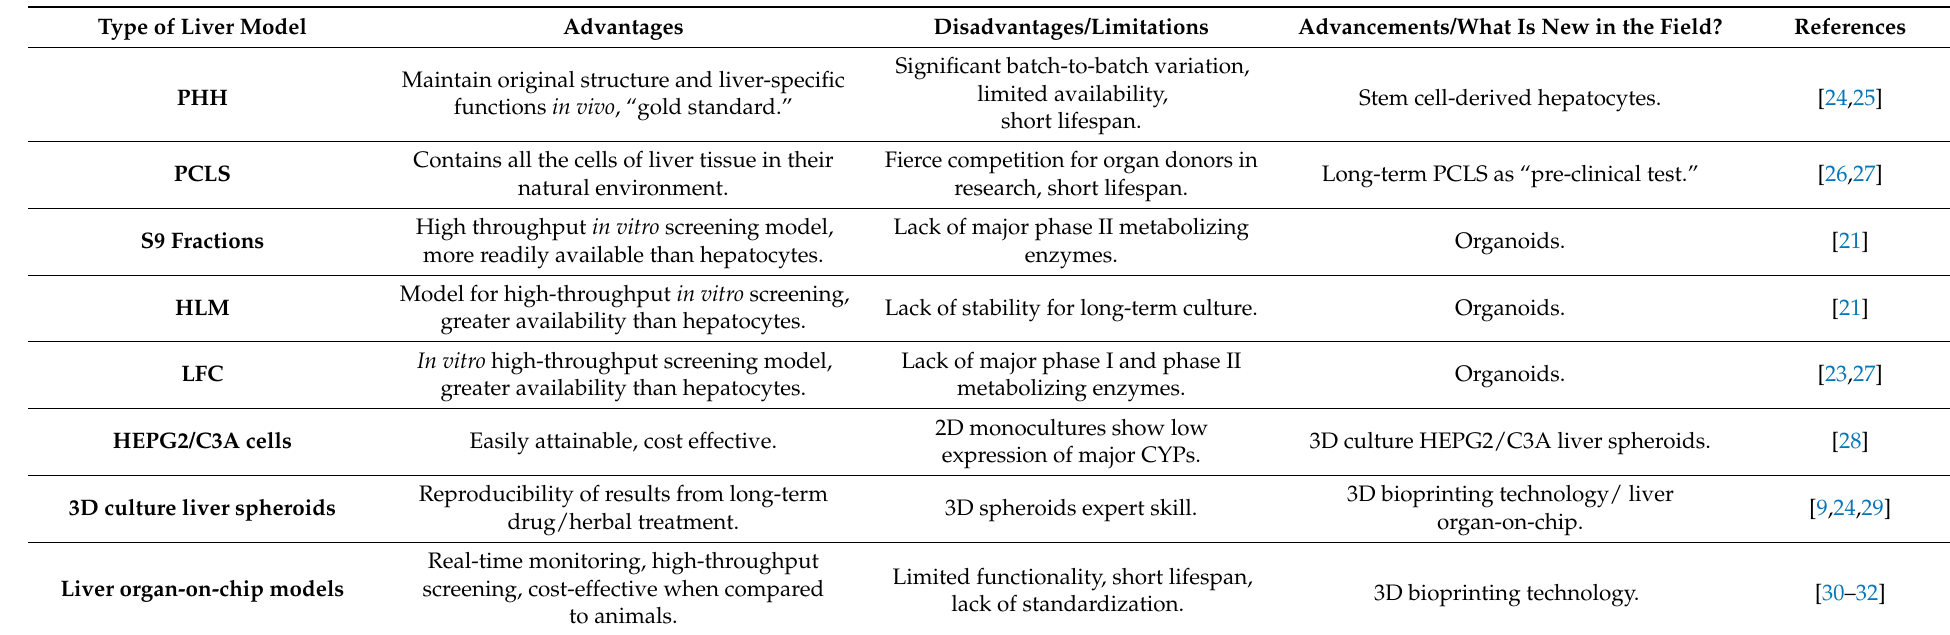
Table 1. The advantages and disadvantages of using each in vitro hepatic model for drug testing/hepatotoxicity and new/future